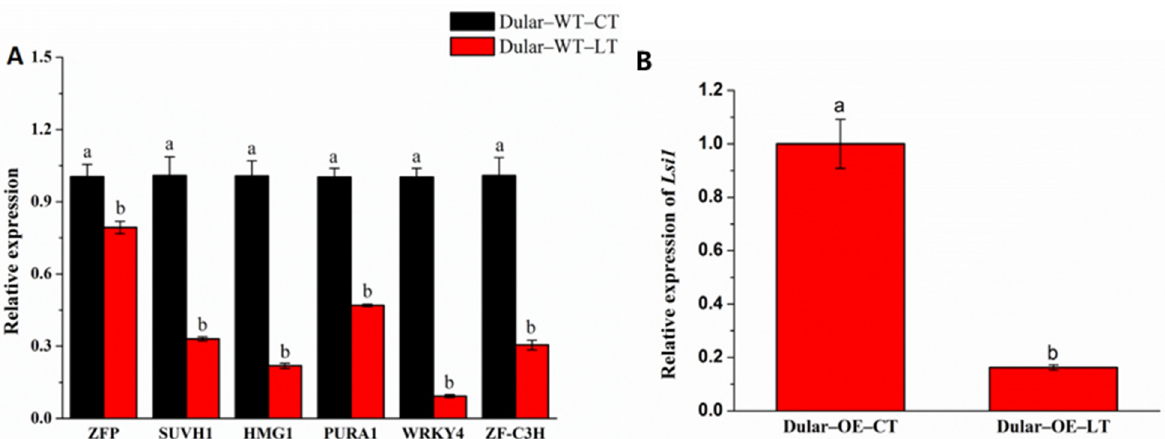
Figure 7. ( A ) The qPCR result of the transcription factor in Dular-WT low and normal temperature. ( B ) The qPCR result of the Lsi1 gene in Dular-OE low and normal temperature. Columns with different letters are significantly different (LSD test, p < 0.05). Error bars are standard error ( ± SE) of three biological replications. CT: normal temperature; LT: low temperature.